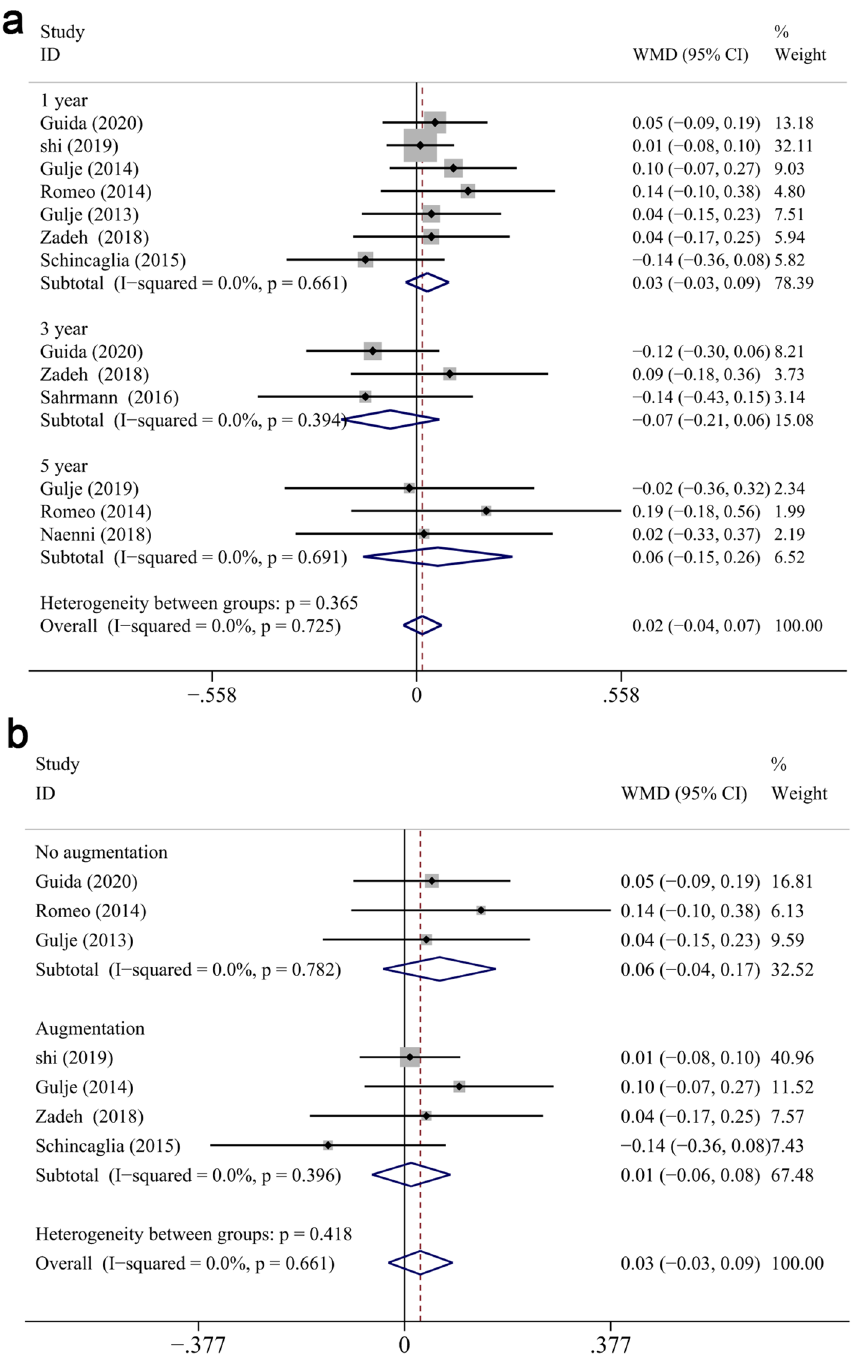
Figure 9. Forest plots (Difference in means) of the marginal bone loss with baseline at prosthesis restoration comparing extra-short with longer implants group at 1-year, 3-year and 5-year follow-up ( a ). Subgroup analyses for effects of augmentation for MBL (from PR) after 1-year measurement ( b ). Negative value in difference in means indicates more MBL in the longer implant